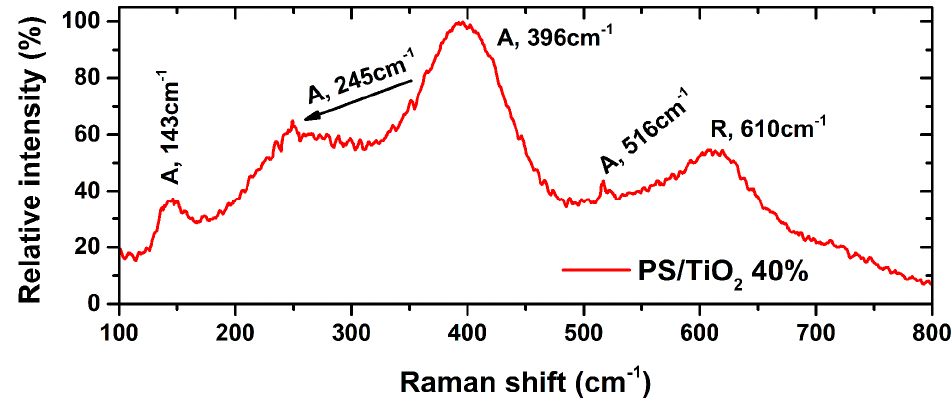
Figure 3. Typical Raman spectra for PS/TiO 2 3D-printed nanocomposite structures.